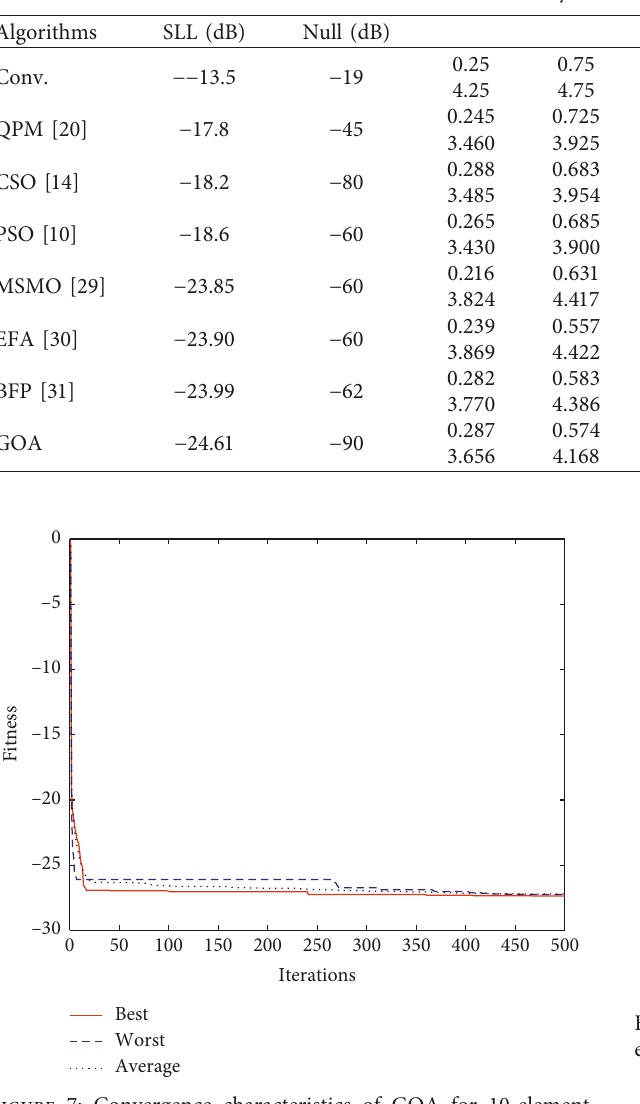
Figure 7: Convergence characteristics of GOA for 10-element linear array in example 3.